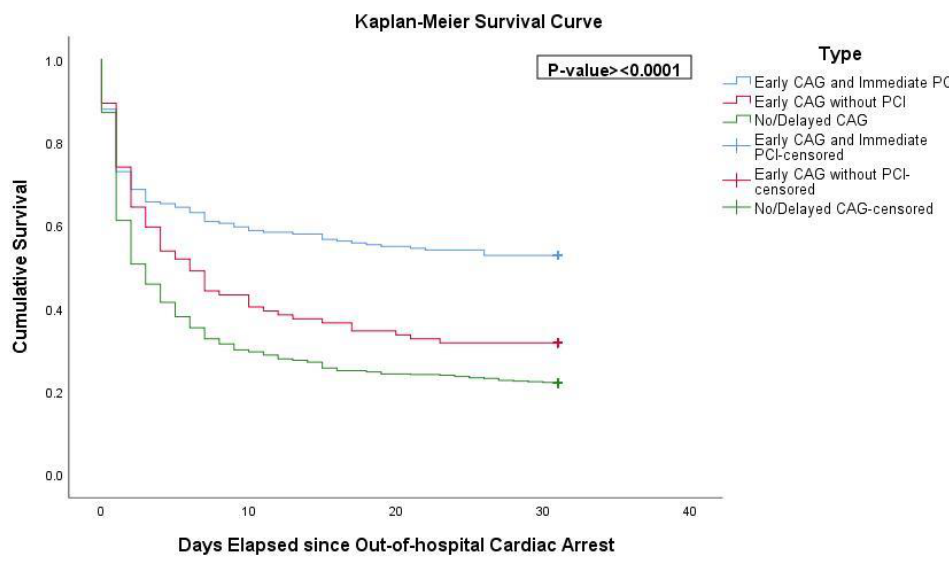
Figure 2. Kaplan–Meier survival curve. Abbreviations: CAG, coronary angiography; PCI, percuta- Figure 2. Kaplan – Meier survival curve. Abbreviations: CAG, coronary angiography; PCI, percuta- neous coronary intervention. neous coronary intervention. Table 3. Predictors of outcomes by logistic